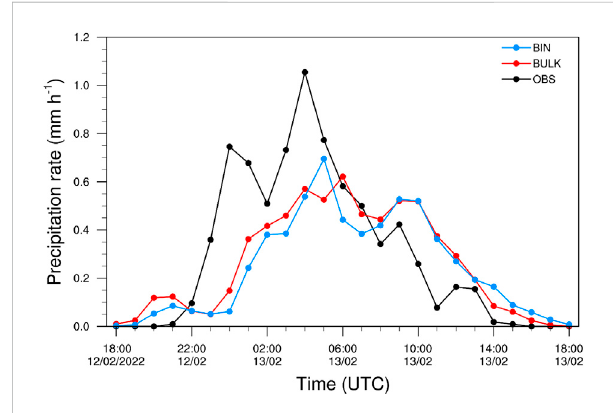
FIGURE 5 Time seriesof area-averaged precipitation rateinthesimulations and observations from 1800 UTC on February 12 to 1800 UTC on February 13, 2022, at 1-h